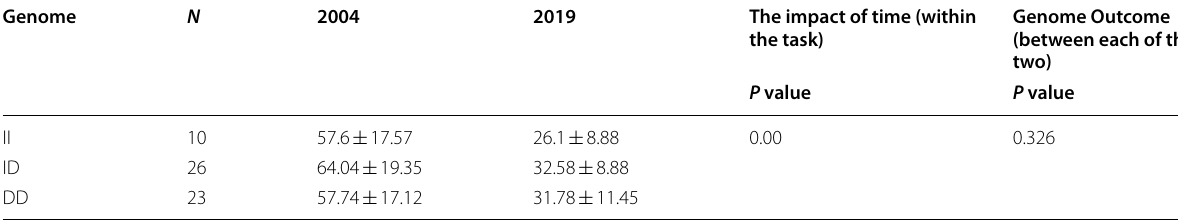
Table 2 The influence of the genome on push-up performance over time